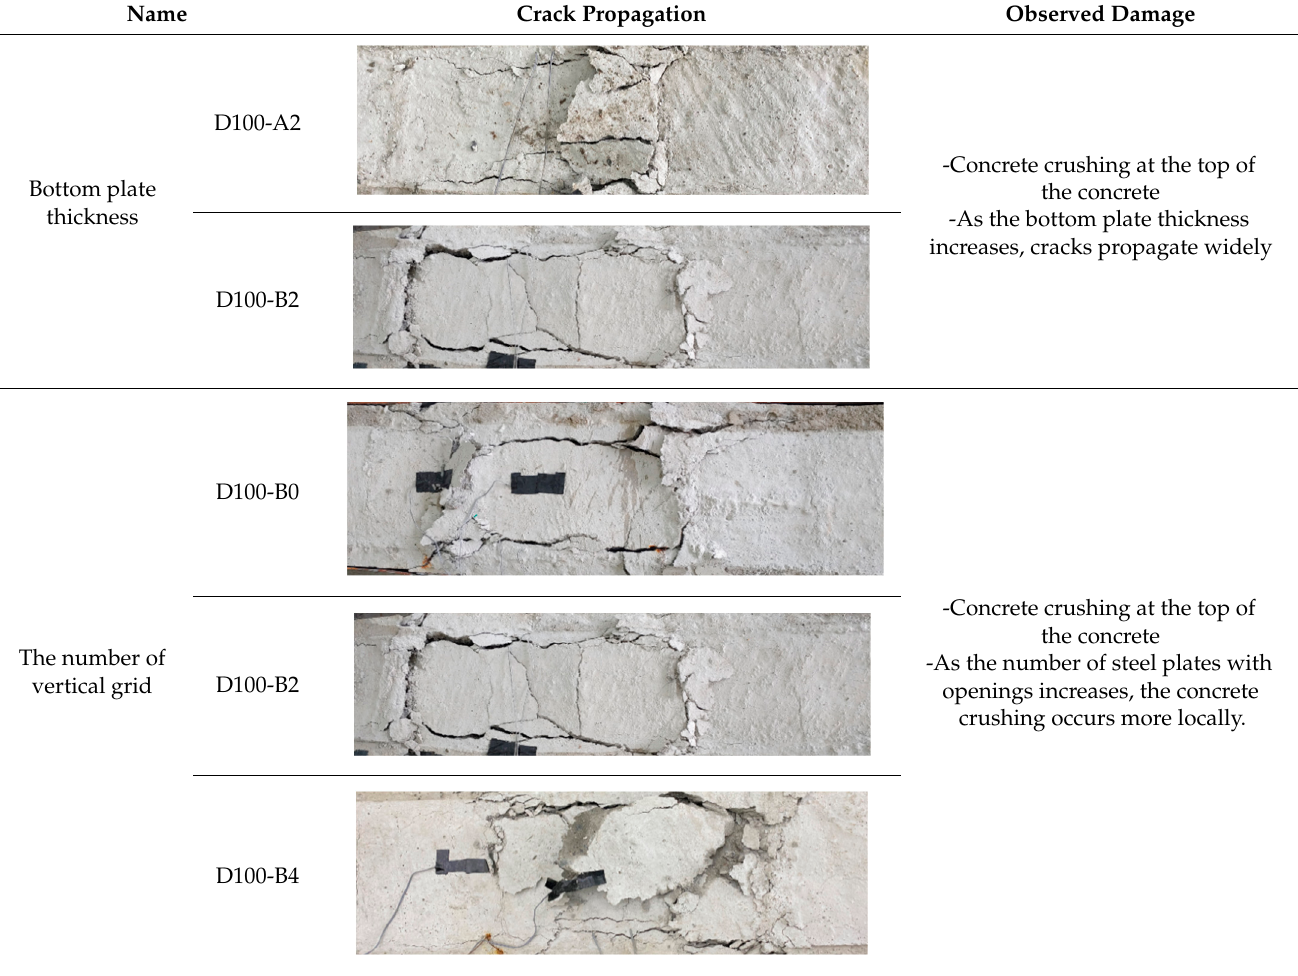
on the bottom plate. The spalling of the mortar was observed differently according to the vertical grid. More spalling occurred in the D100-B0 specimen without the vertical Figure 11. The shape of the test specimen after a flexural test.